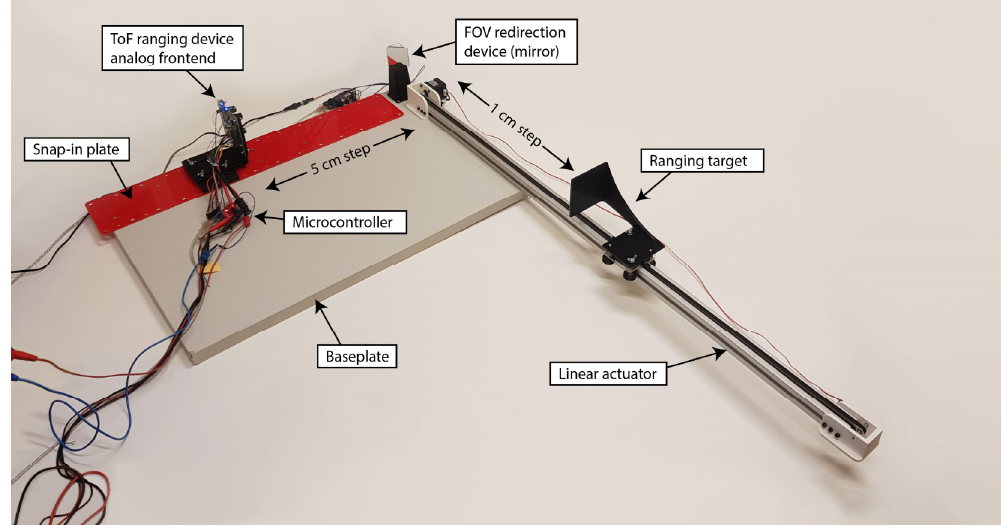
Figure 6. Measurement setup as used in the experiments. Photographed configuration depicts a state during testing of effects of a clean first surface mirror on ranging where distance between the ranging device and the mirror was 40 cm .